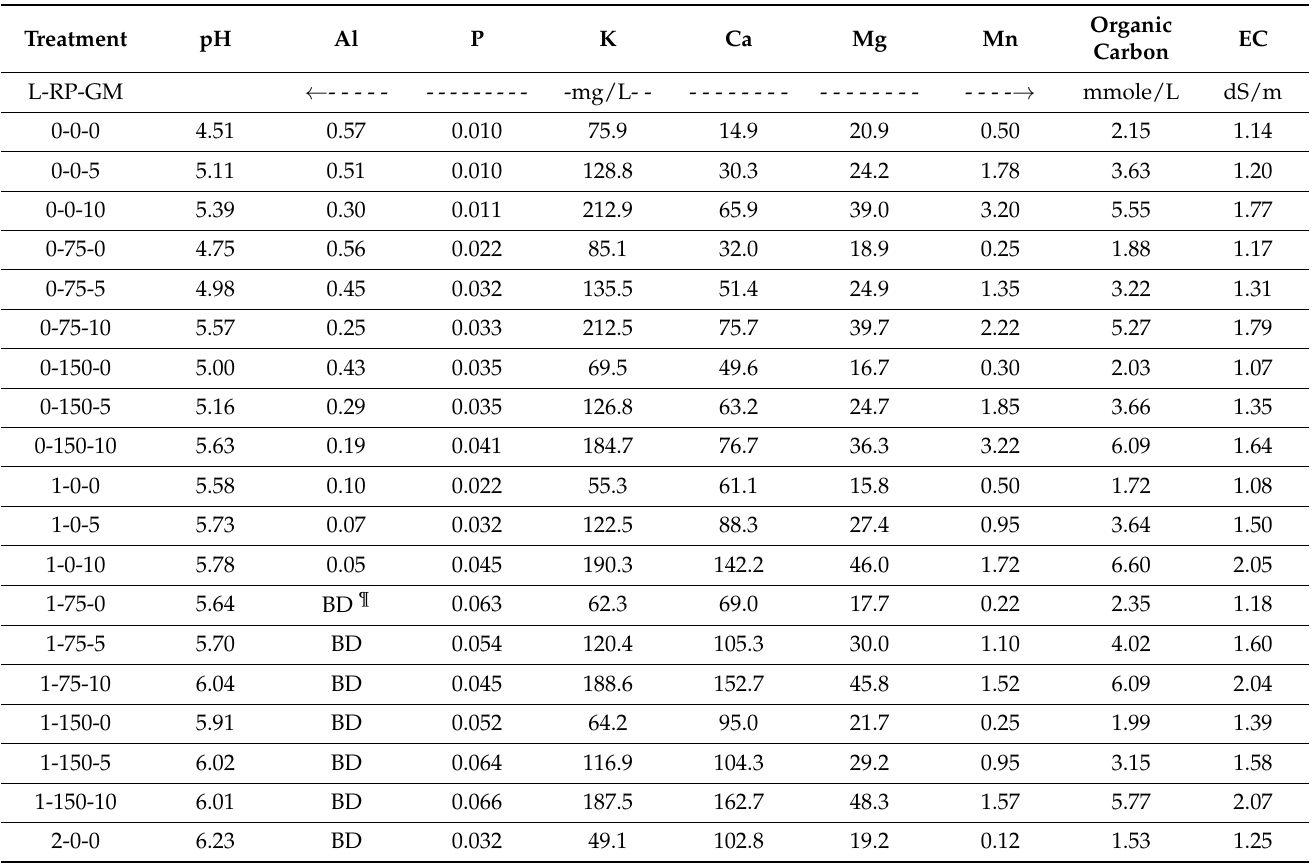
Table 4. Soil-solution composition of an acid Oxisol as affected by lime, rock phosphate, and cowpea green manure.